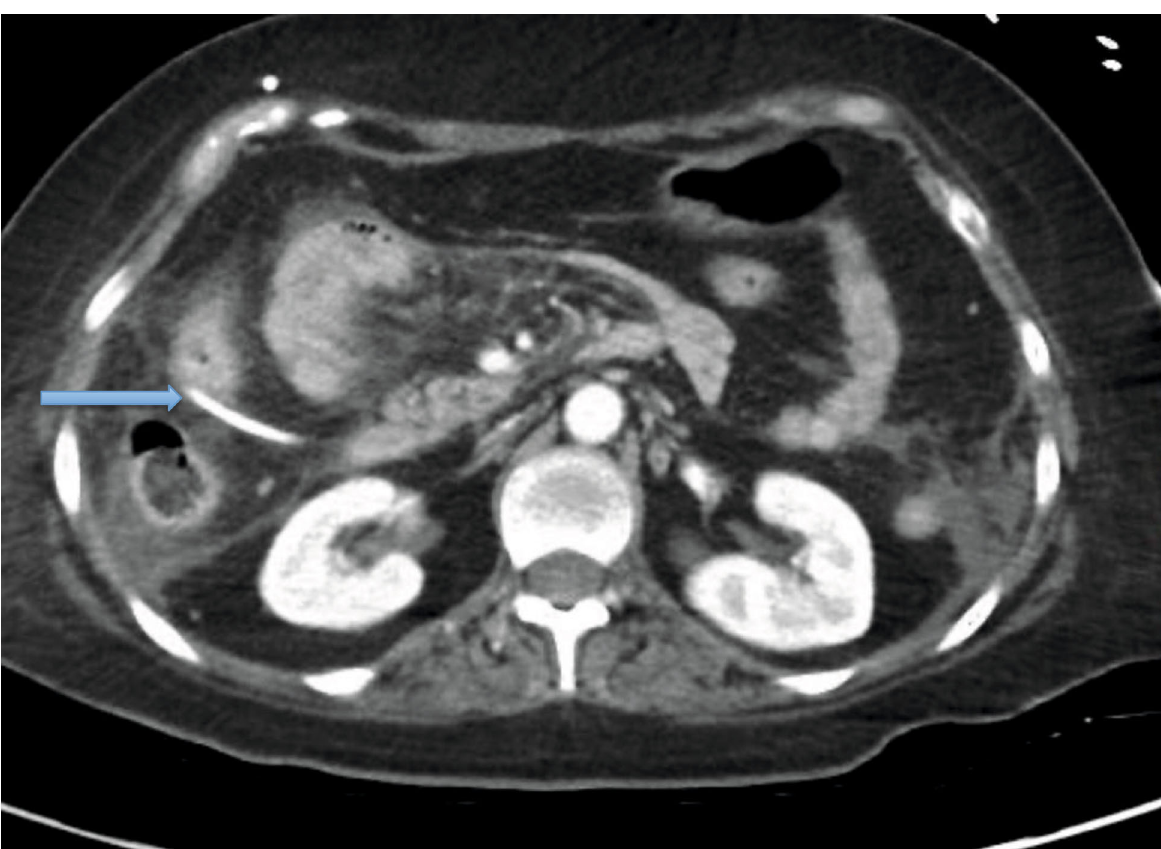
Figure 1: CT of the abdomen showing dilated loops of bowel concerning for enteritis and ventriculoperitoneal shunt (blue arrow).